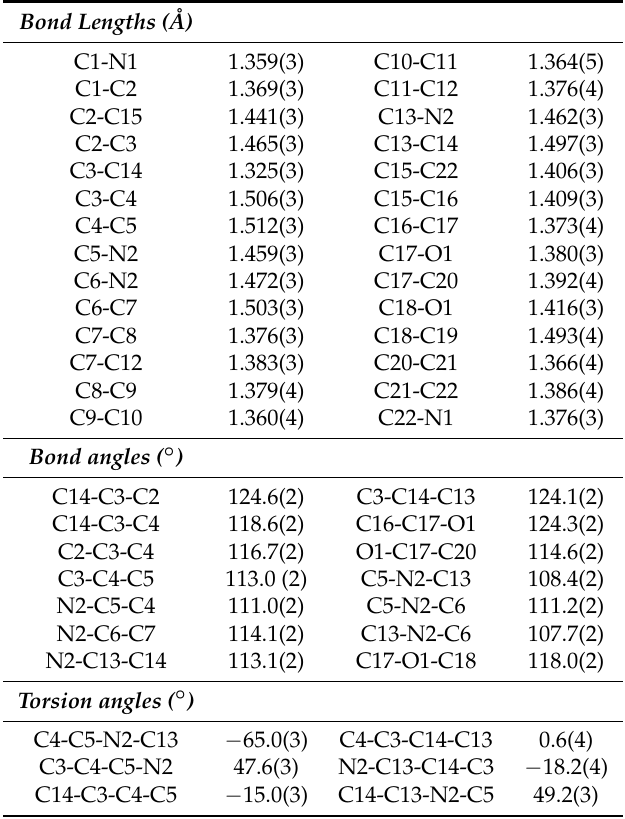
Table 2. Interatomic distances and selected bond angles.